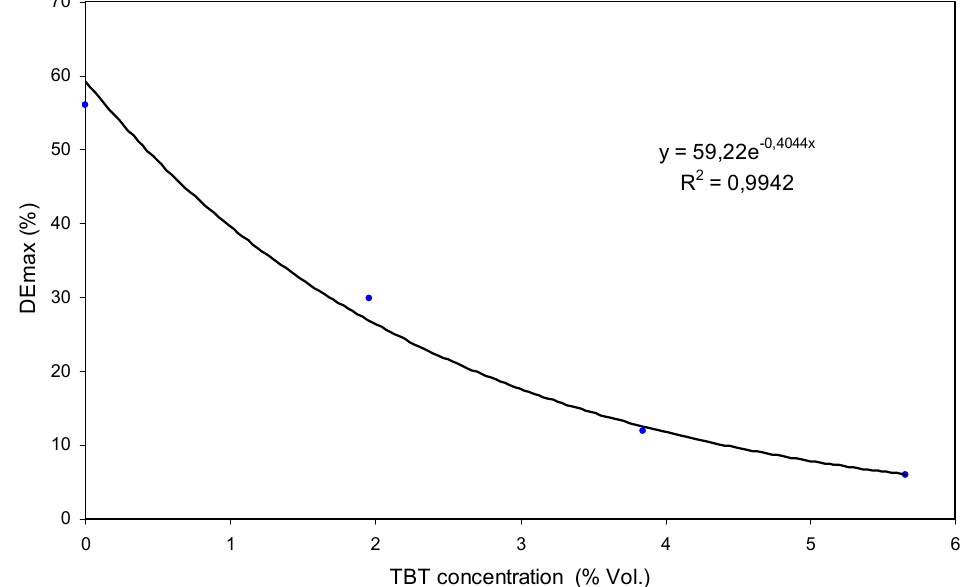
Figure 10. Maximum diffracted efficiency (DEmax) values from Figure 9 versus TBT concentration.